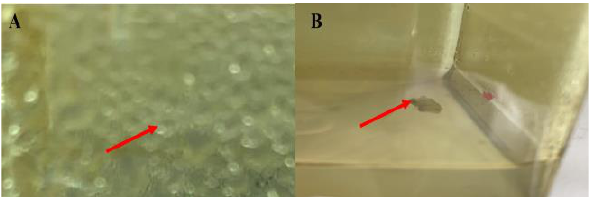
Figure 2: Shoot bud formation on A: T3 (MS + 1.0 mg/l IBA + 2.5 mg/l BA) and B: T5 (MS + 2.0 mg/l BA + 0.10 mg/l IBA + 0.3 mg/l GA3) Note: Red arrows show the shoot